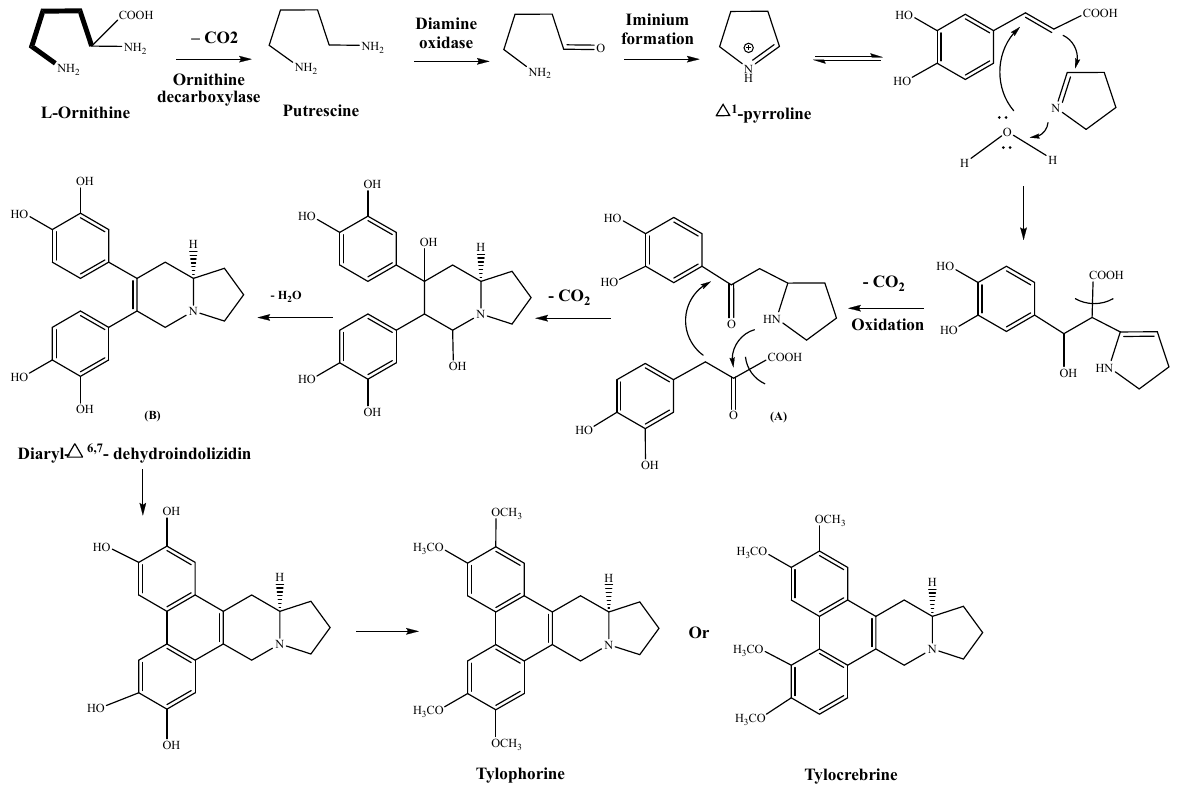
Figure 1. Biogenetic outline of the genus Tylophora alkaloid.